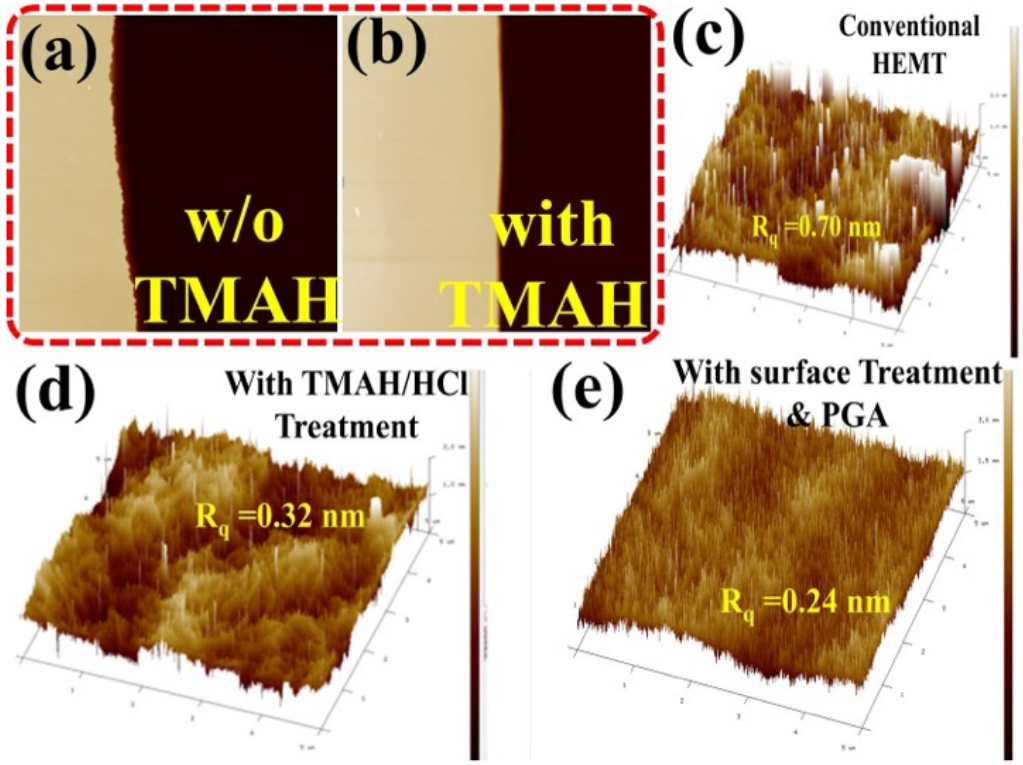
Figure 2. AFM profile of AlGaN/GaN device after ICP mesa etching ( a ) without and ( b ) with TMAH treatment. The 3D AFM images of the device ( c ) without, ( d ) with dual surface treatment and gate annealing modulation.